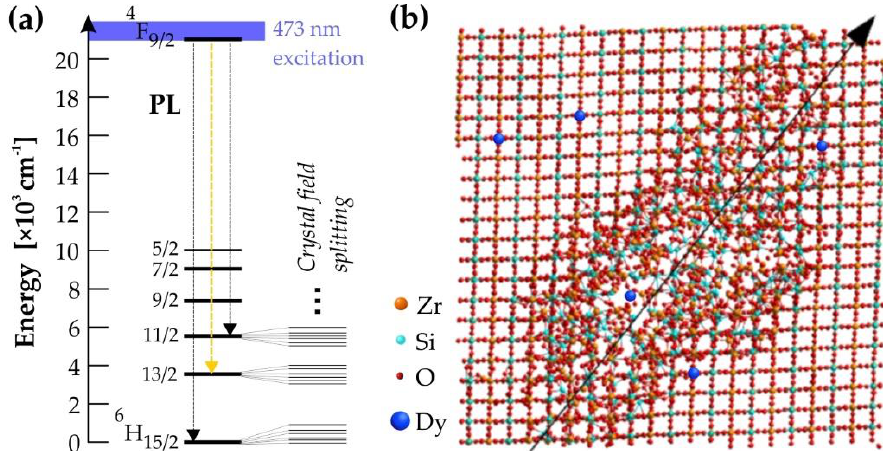
Figure 2. ( a ) A schematic energy-level diagram of Dy 3+ (4 f 9 electron configuration) with its major luminescence transitions after excitation with a blue 473 nm laser (electronic level energies after Carnall et al. [70]). The free-ion levels are fine-split into so called “Stark levels” in dependence of the local crystal field. A stressed, altered, or completely destroyed structural environment has a great impact on crystal-field fine splitting, i.e., the luminescence emission. ( b ) Graphical representation of a molecular-dynamics simulation of a single 30 keV recoil from a decay event in zircon (modified after Trachenko et al. [69]). The arrow indicates the moving direction of the decayed daughter nuclei. Blue balls represent random substitution of REE 3+ ions (i.e., Dy 3+ ) on Zr-sites. Radiation damage alters the local structural environment of Dy 3+ ions in affected areas.